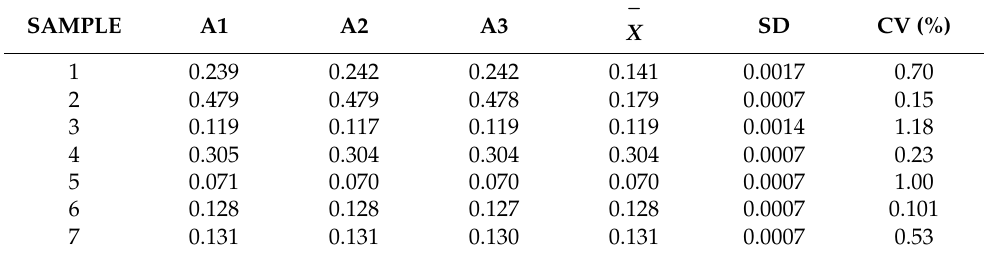
Table 6. Absorbances obtained for lypophilic extracts of cream samples (Folin-Ciocalteu method).